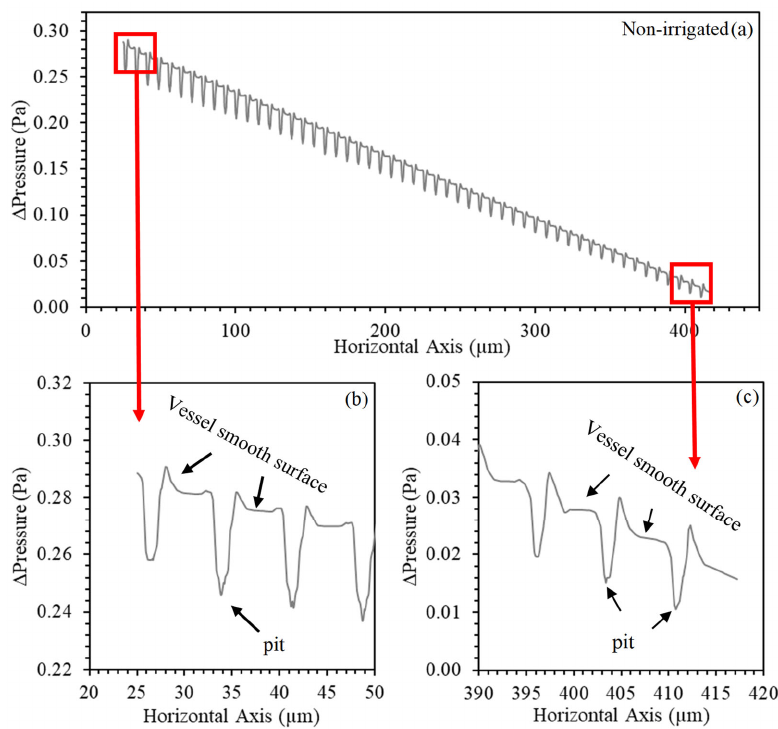
Figure 8. Numerical predictions of the pressure profile (Pa) generated along with the anatomical model in the longitudinal section of the non-irrigated Khaya grandifoliola xylem vessels. ( a ) The entire longitudinal axis; ( b ) input detail and ( c ) output detail.